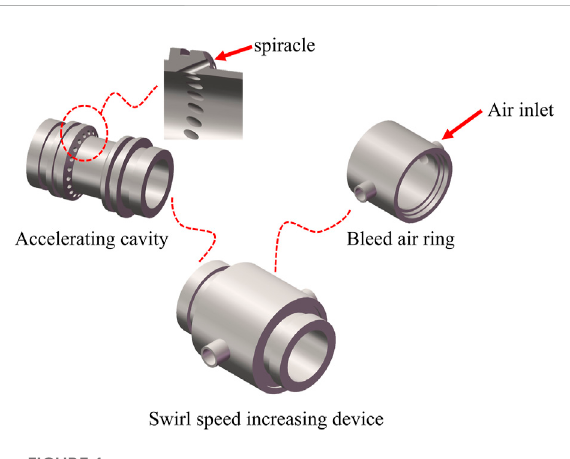
FIGURE 1 Structure diagram of the swirl speed-increasing